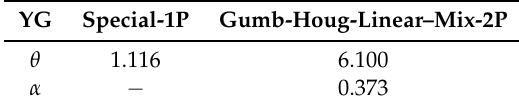
Table 10. Best-fit copulas parameters for the young